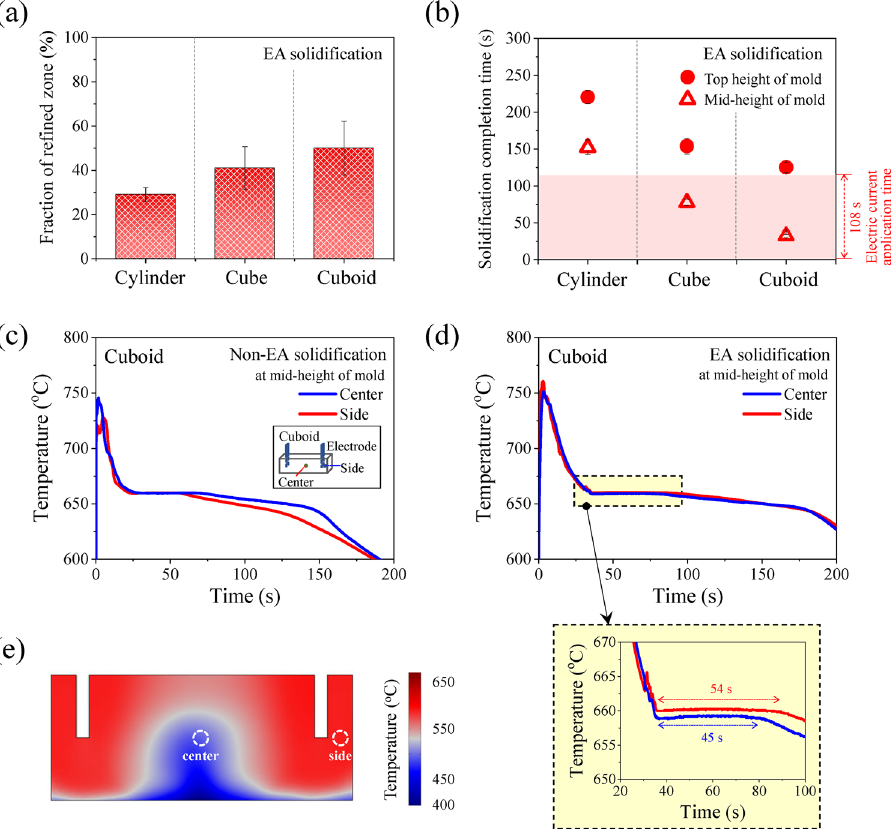
Figure 9. ( a ) Fraction of the refined zone in the longitudinal YZ plane in EA solidification. ( b ) Solidification time at the mid- and top height of the mold in EA solidification for the cylinder-, cube-, and cuboid-shaped cavities. Measured cooling curve at the mid-height of the cuboid-shaped cavity in ( c ) non-EA solidification and ( d ) EA solidification. ( e ) Numerically calculated 2D temperature distribution map of XZ plane in cuboid- shaped